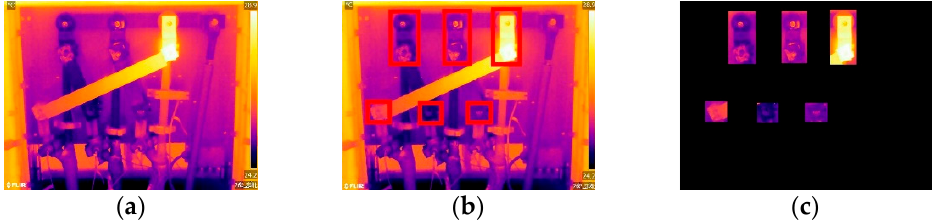
Figure 7. Result of eliminating the interference information in the image of the grounding box: ( a ) original infrared image; ( b ) detecting result of Faster RCNN network; ( c ) extracting results of con- nections.